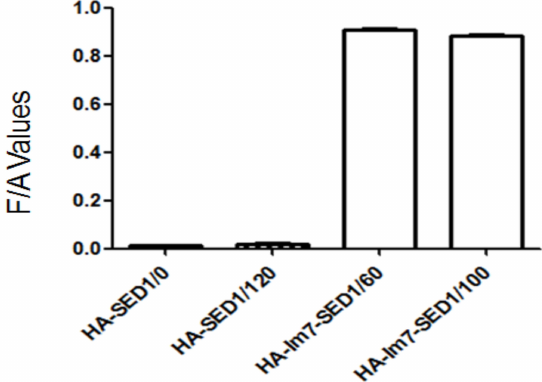
Figure 8. The calibration curve and linear regression equation of the CL7-sfGFP fusion proteins in TBS bu ff er (pH 7.6).